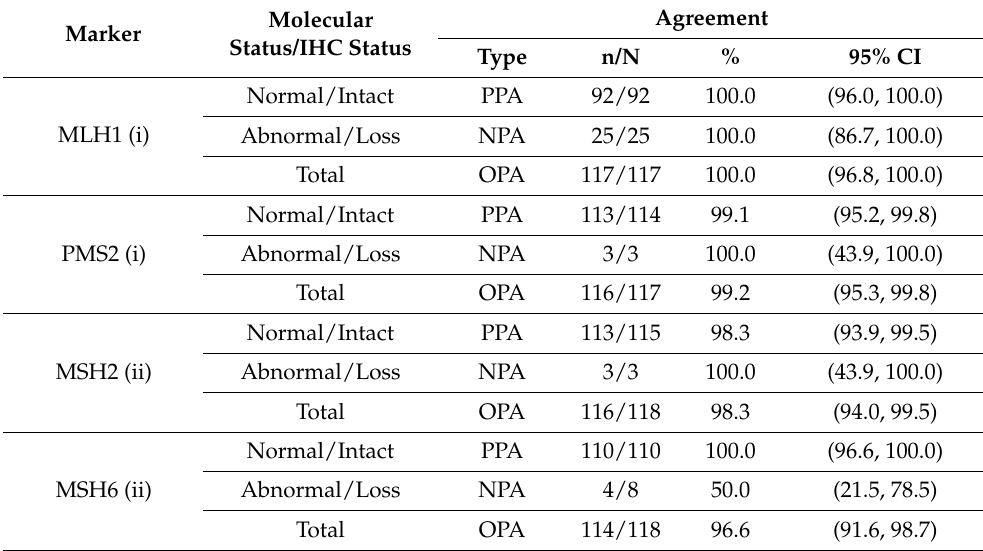
Table 2. Agreement between IHC using anti-MLH1, anti-PMS2, anti-MSH2, and anti-MSH6 antibod- ies and NGS